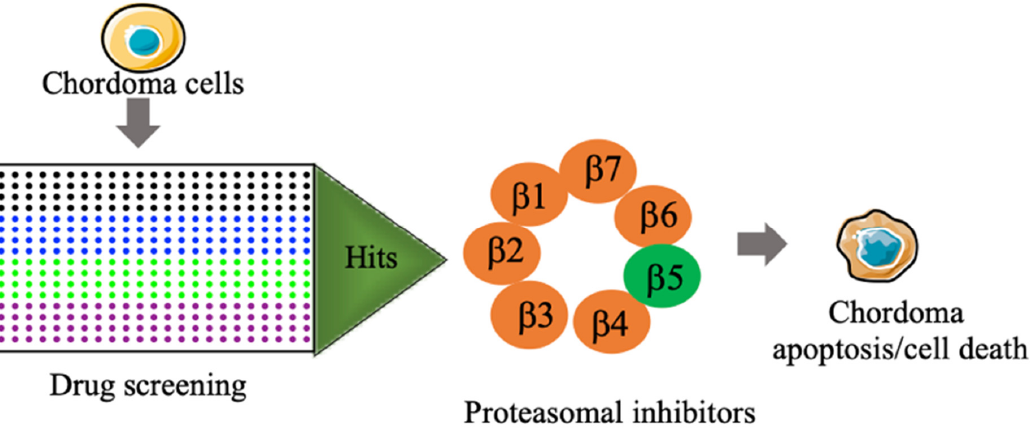
Figure 6. Schematic diagram showing small molecule inhibitor/proteasomal inhibitors for reduc- ing chordoma cell proliferation.